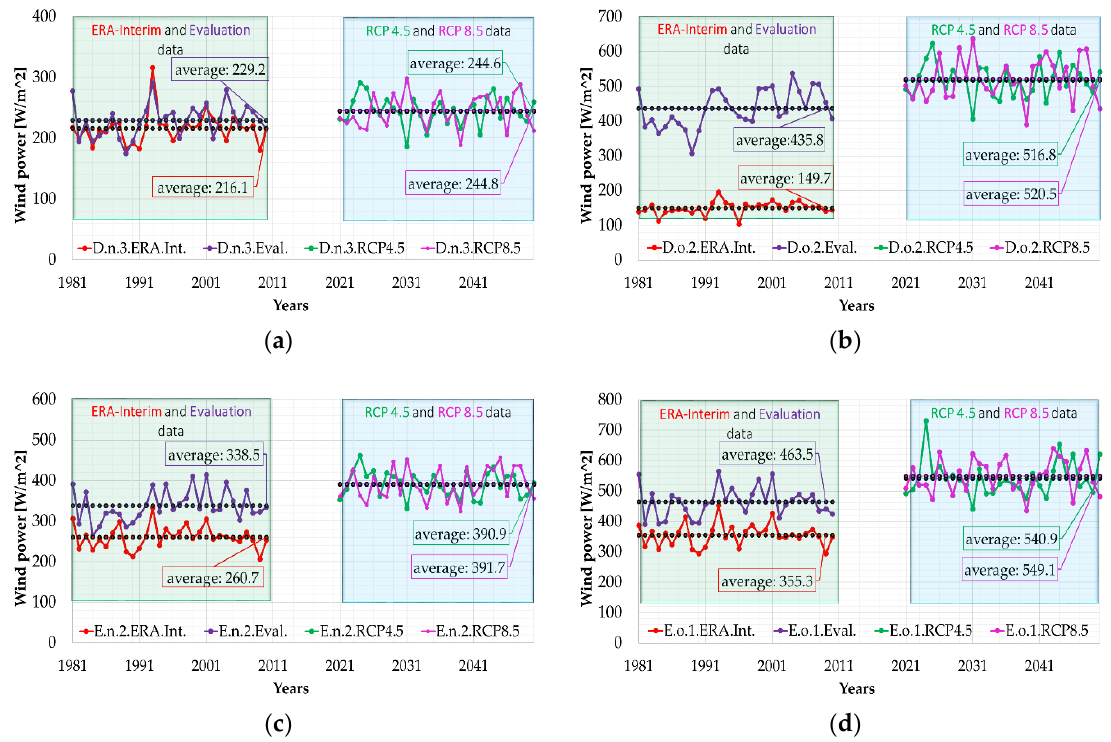
Figure A3. Annual wind power averages at 100 m height for the points: ( a ) D.n.3, ( b ) D.o.2, ( c ) E.n.2 and ( d ) E.o.1. ERA.Int and Eval data, time interval 1981–2010; RCP4.5 and RCP8.5 data, time interval 2021–2050. For each dataset, the average of the wind power corresponding to the entire time interval is indicated in the box.